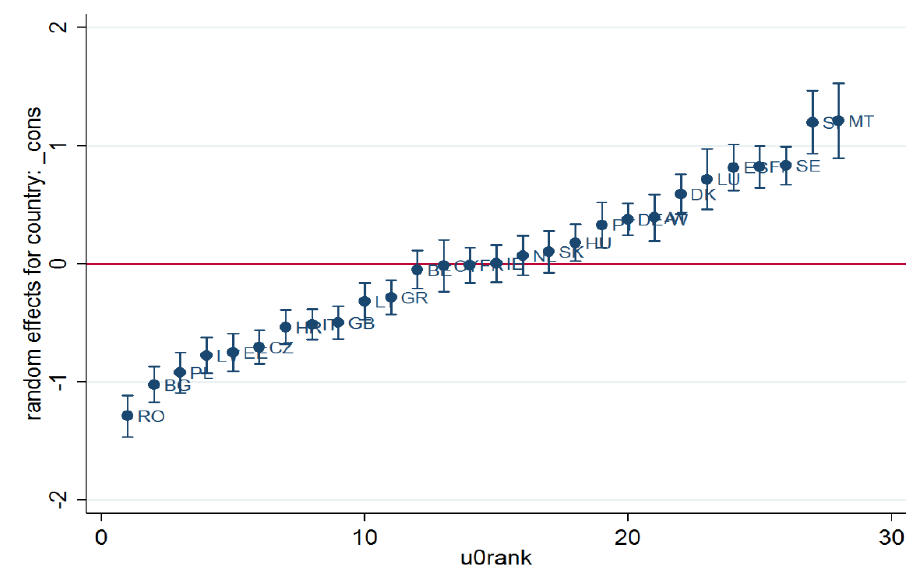
Figure A1. Country-level effects of null model for the decision to undertake climate change individual actions. Source: Author’s contribution.